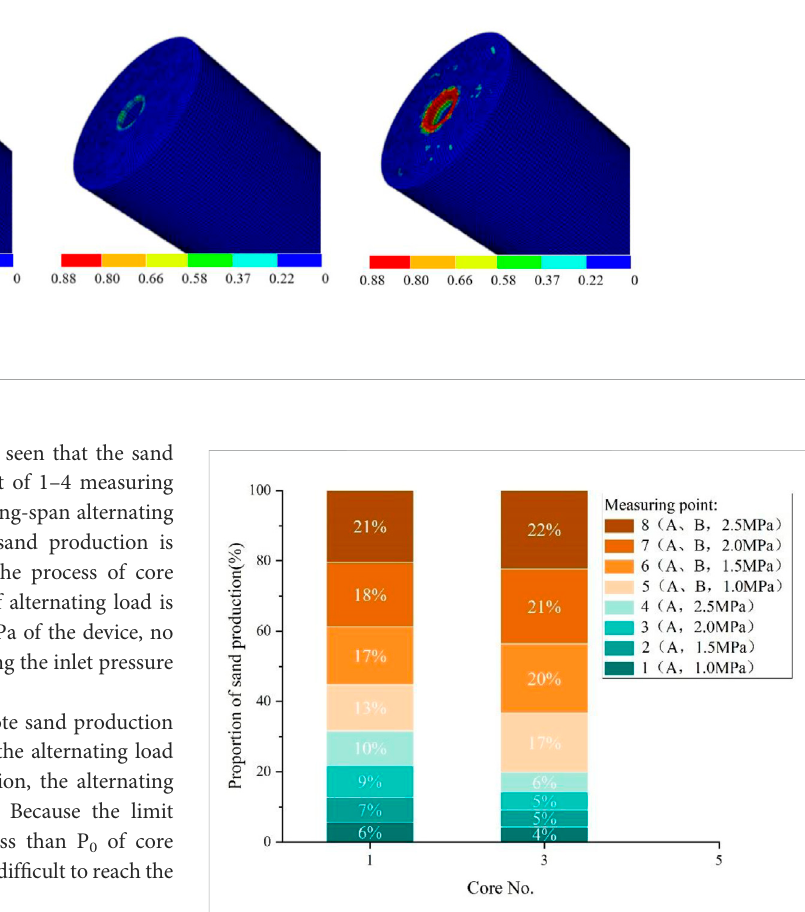
FIGURE 8 Proportion of sand production in each stage of core I, III and